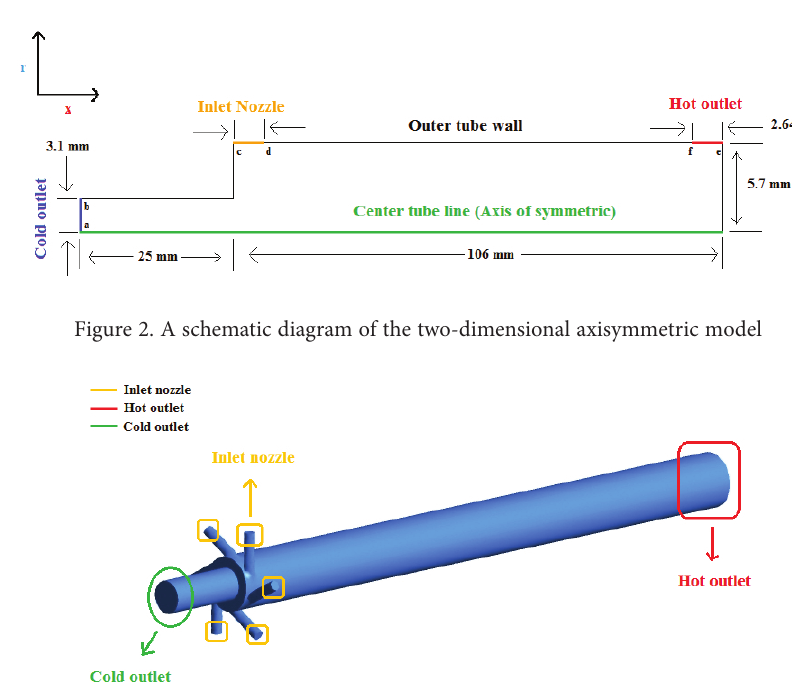
Figure 3. A three-dimensional geometry of a vortex tube with an inlet and